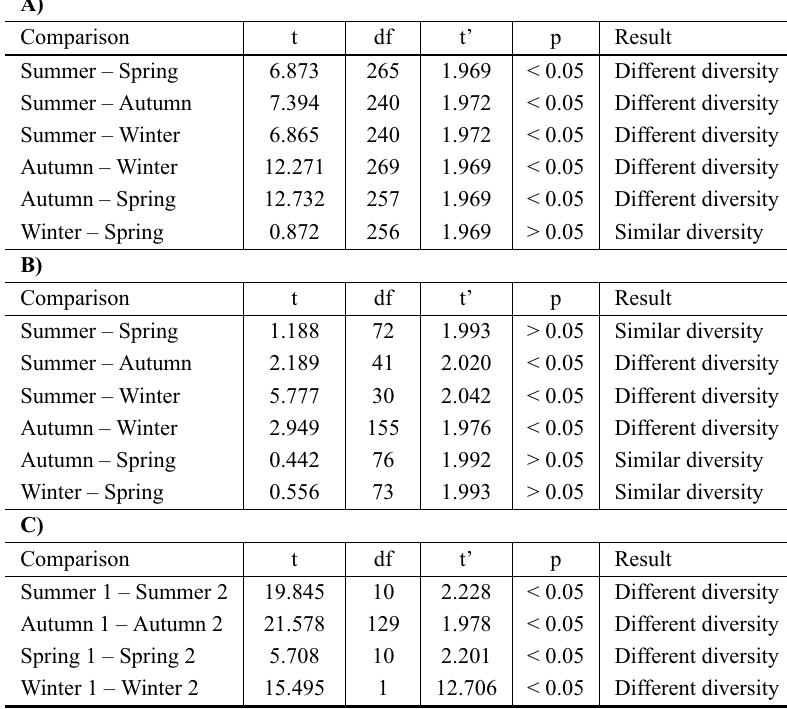
Values of the Hutchinson test, at 5% significance, among the seasonal diversity indexes of coypu’s diet ( Myocastor coypus ) from both areas. t = test t; df = degrees of freedom. A) Area 1 – Santa Isabel do Sul wetlands; B) Area 2 – Santa Marta Farm; C) Comparison between both